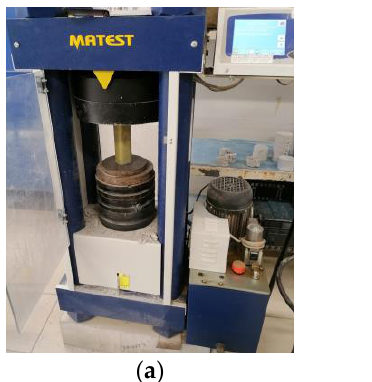
Figure 11. ( a ) Three-point scheme for the bending strength measurement; ( b ) three-point scheme for the shear strength measurement.